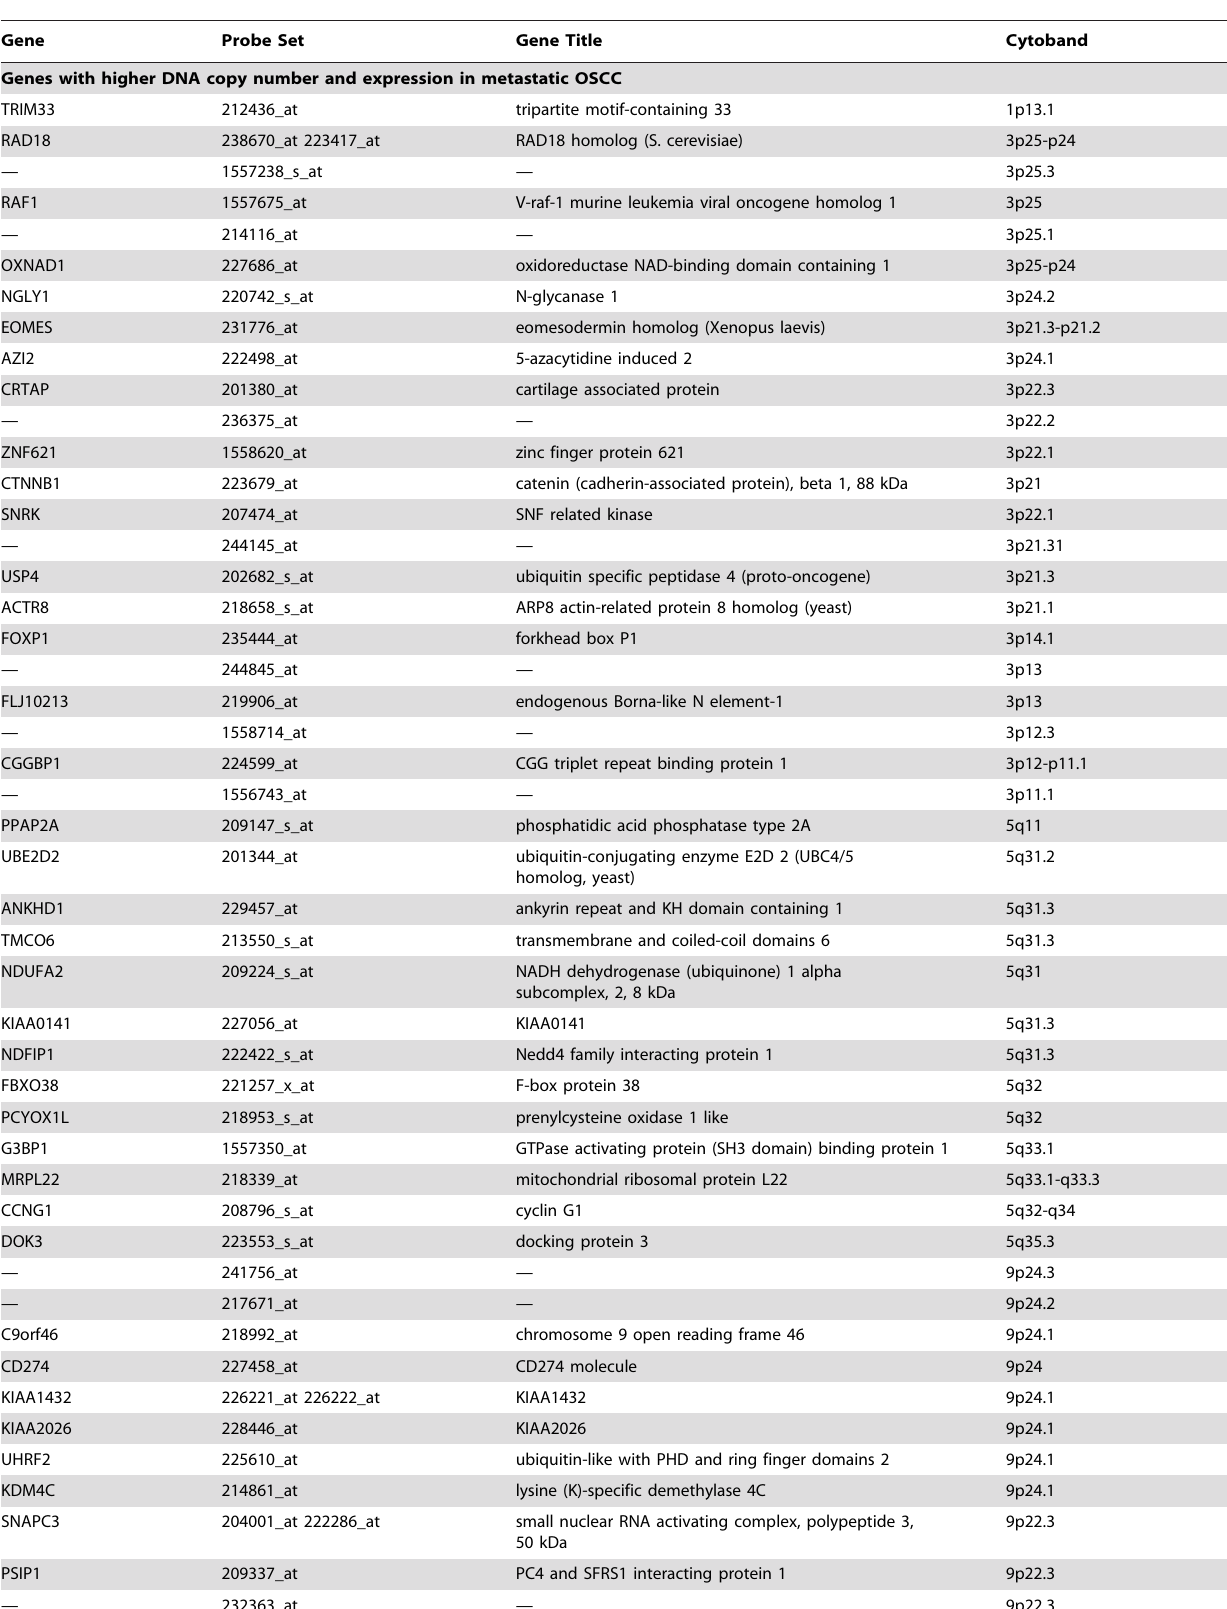
Table 1. DNA copy number–associated and differentially expressed transcripts in metastatic OSCC.